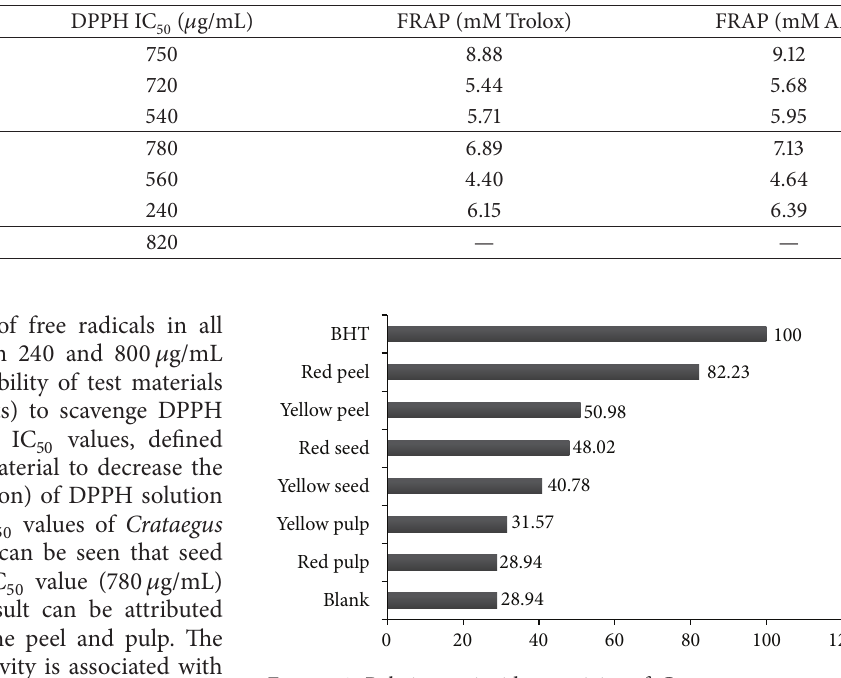
Figure 1: Relative antioxidant activity of Crataegus extracts and positive control (BHT) in 𝛽 -carotene/linoleic acid